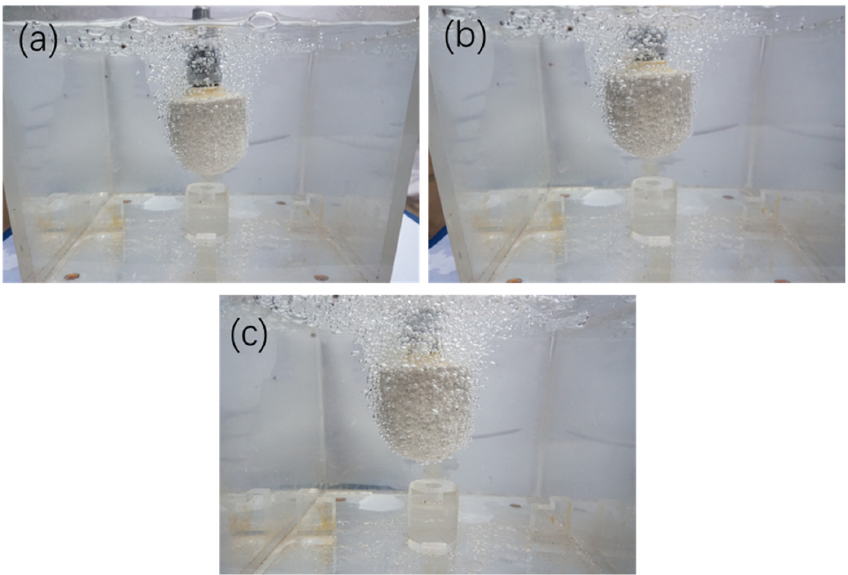
Figure 7. The hydraulic simulation photo of the porous nozzle with different proportions of pore- forming agent: ( a ) 0, ( b ) 3 wt.%, ( c ) 6 wt.%.